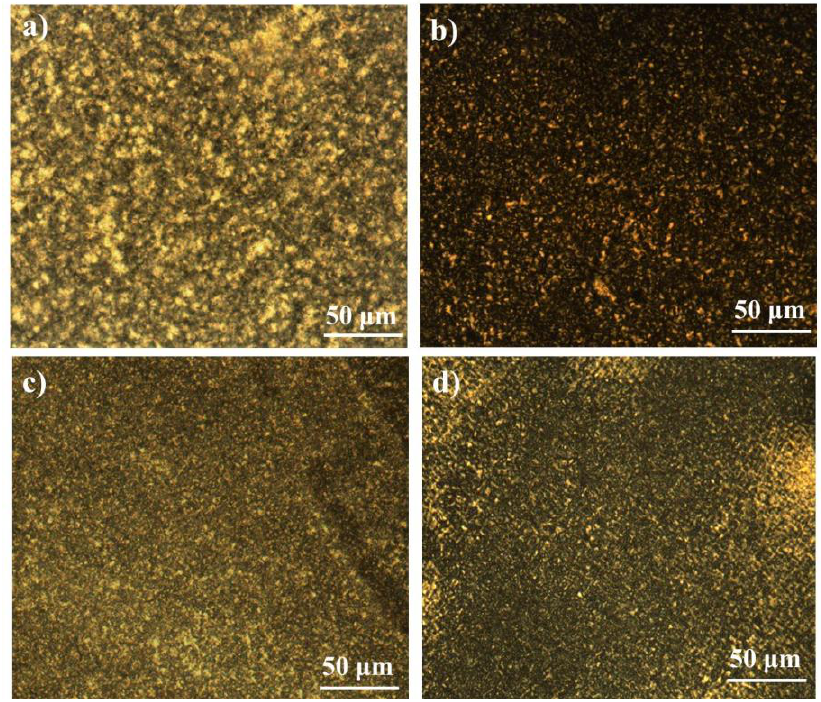
Figure 7. Polarized optical microscopy (POM) images for neat PA12,PK and their blends: ( a ) PA12; ( b ) A8K2; ( c ) A5K5; ( d ) PK. ( b ) A8K2; ( c ) A5K5; ( d )